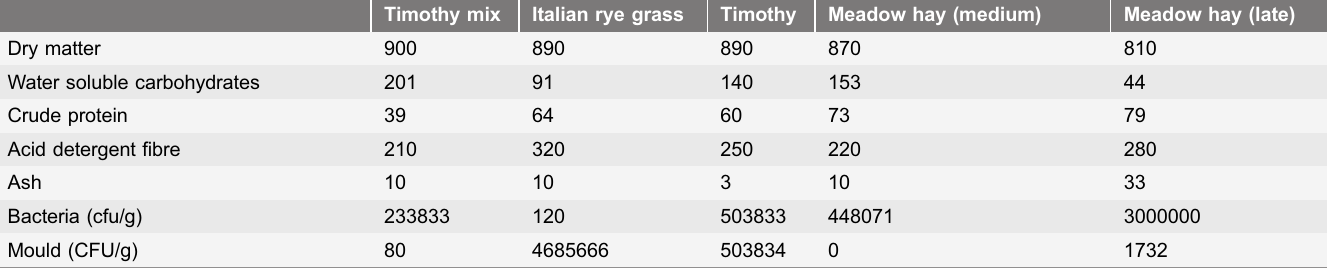
Table 1. Mean nutrient contents (g/kg DM), bacteria and mould colony forming units (CFU/g) of 5 different types of UK conserved hay.